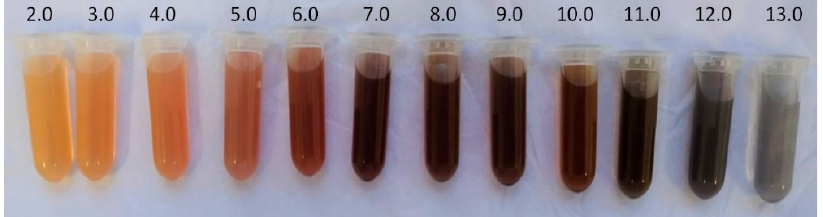
Figure 2. Visual aspect of AgNPs synthesized as a function of the pH of the sodium citrate solution.